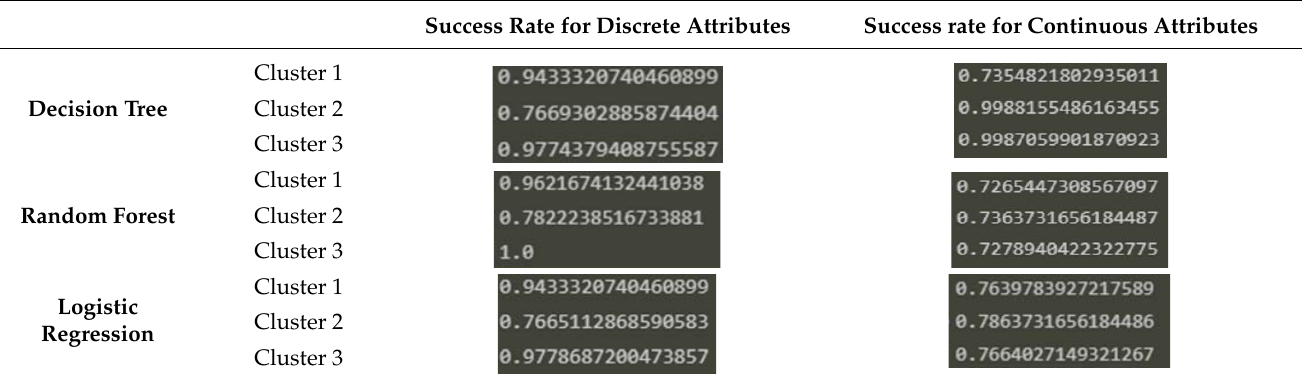
Table 5. The results of the prediction by the RUL method .